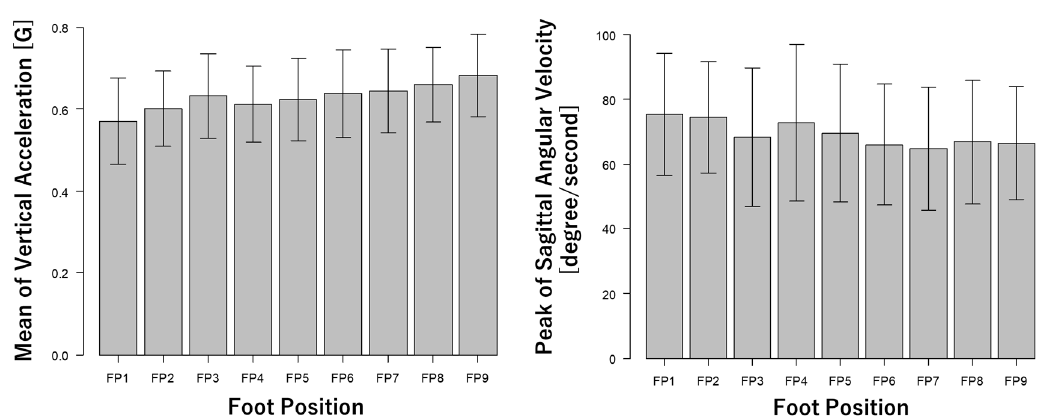
Figure 4. Mean of vertical acceleration and peak of sagittal angular velocity obtained from inertial sensor. Positive of acceleration mean superior direction. Positive value of angular velocity mean trunk extension. Values are mean ± standard deviations. FP: foot position.